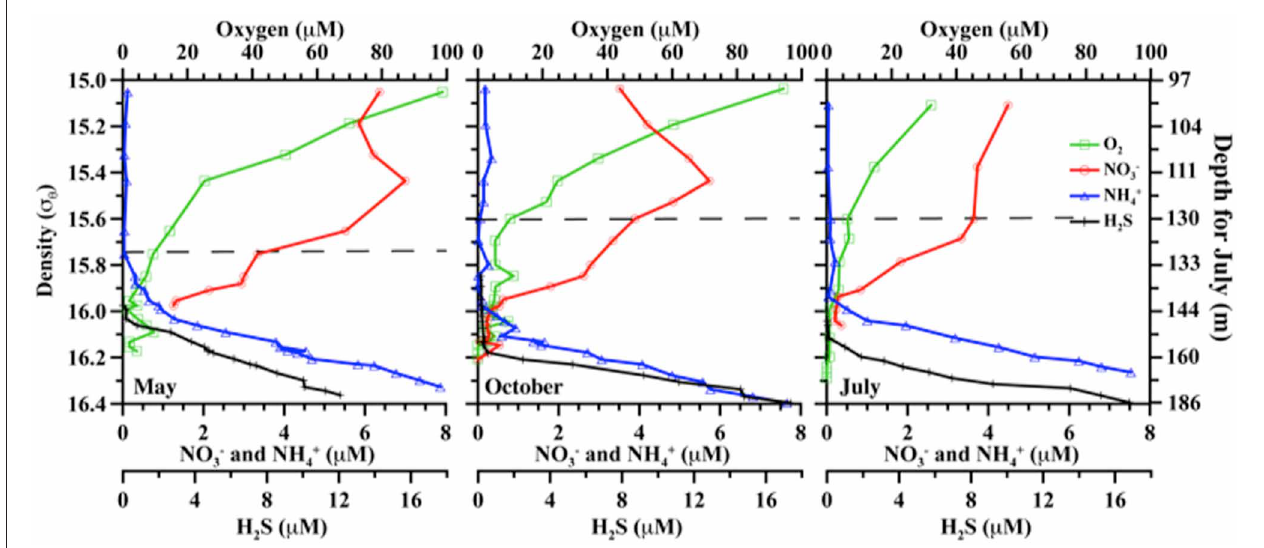
FIGURE 1 | Comparative chemical profiles for the three different cruises. Markers indicate discrete samples. Plots are versus density as absolute depths are less consistent. For reference, July 2008 also includes absolute